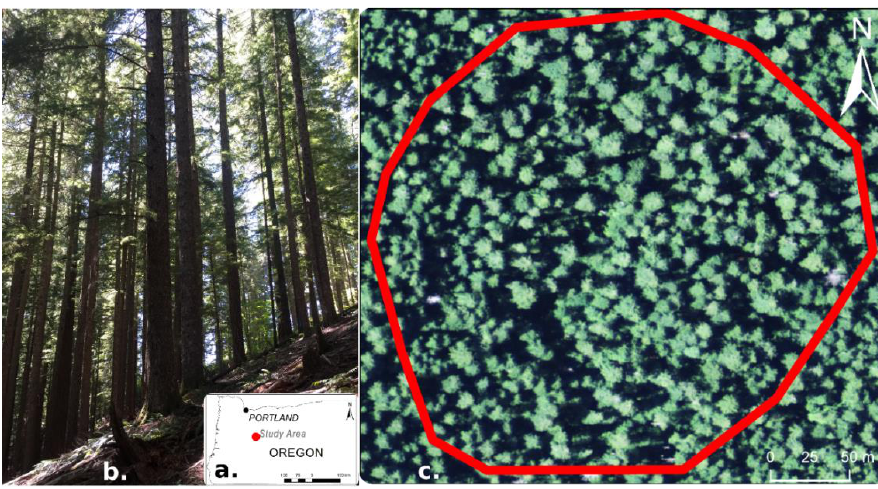
Figure 2. Study area: ( a ) General location. ( b ) A perspective image inside the stand. ( c ) Nadir view of the point cloud.